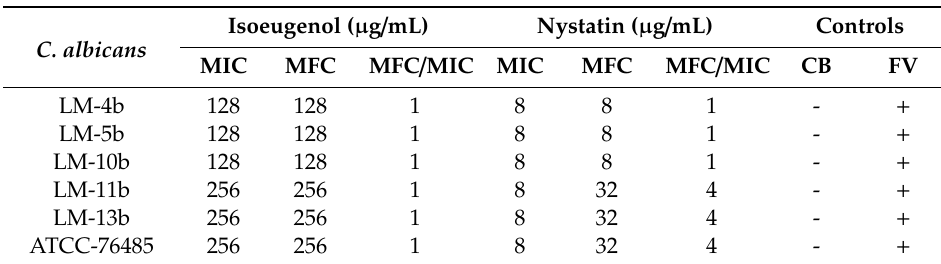
Table 2. Minimum Inhibitory Concentration (MIC) and Minimum Fungicidal Concentration (MFC) of isoeugenol and nystatin on C. albicans